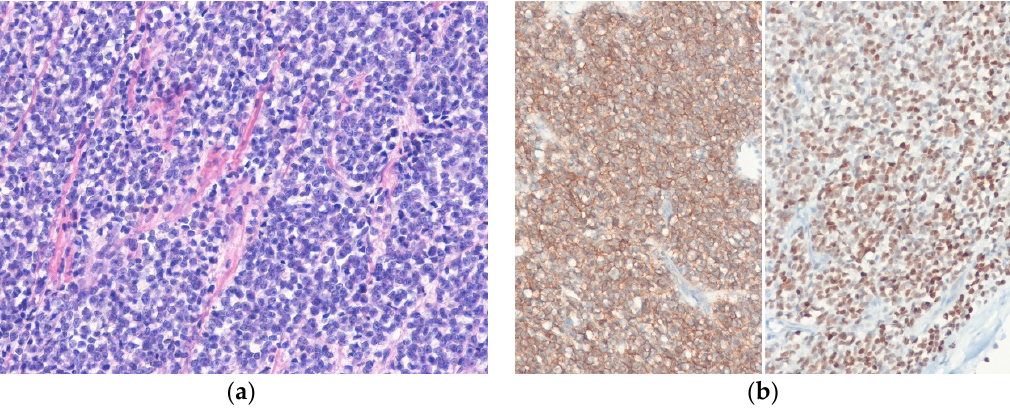
Figure 13. Extraskeletal Ewing sarcoma. ( a ) The tumor is composed of uniform small round tumor cells arranged in vaguely lobular pattern. The tumor cells have finely dispersed chromatin and scanty cytoplasm. ( b ) The tumor cells show diffusely membranous expression for CD99 (left) and diffusely nuclear expression for NKX2.2 (right) (H&E stain, original magnification 100× a ; CD99 and NKX2.2 immunostain, original magnification 100× b ).